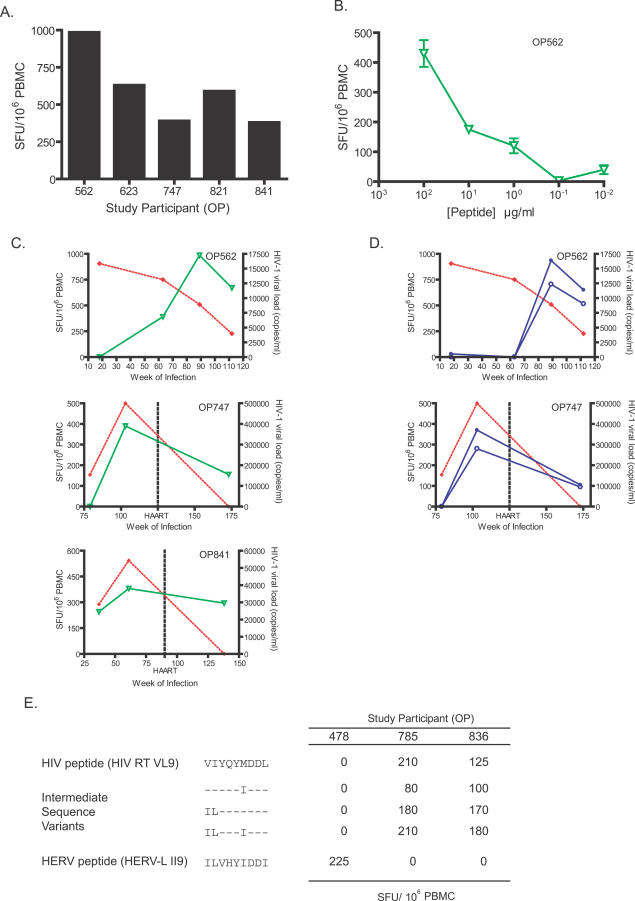
Cross-Sectional and Longitudinal ELISPOT Responses to HIV-1- and HERV-Derived Peptides and Sequence Variants in HIV-1-Positive Study Participants(A) Responses in five HIV-1 positive study participants to the unique HERV peptide HERV-L IQ10.(B) A titration of peptide concentrations for HERV-L IQ10 (open green triangles) peptides for an HIV-1-positive study participant.(C) Responses in three individuals to a unique HERV peptide are shown as inverted green triangles. HIV-1 plasma viral loads are represented as filled red diamonds and are determined with clinical assays for viral load (bDNA and PCR assays).(D) Responses in two representative HIV+ study participants to an HIV-1 and HERV peptide pair with a high level of amino acid identity are shown in blue as open and filled circles, respectively.
(E) Responses in three study participants to an HLA-A2-restricted HIV-1 epitope peptide (HIV RT VL9) and a HERV-L peptide (HERV-L II9) are shown, along with responses to three intermediate sequence variant peptides in which selected amino acids in the HIV-1 epitope were replaced with the equivalent amino acid found in the HERV peptide.